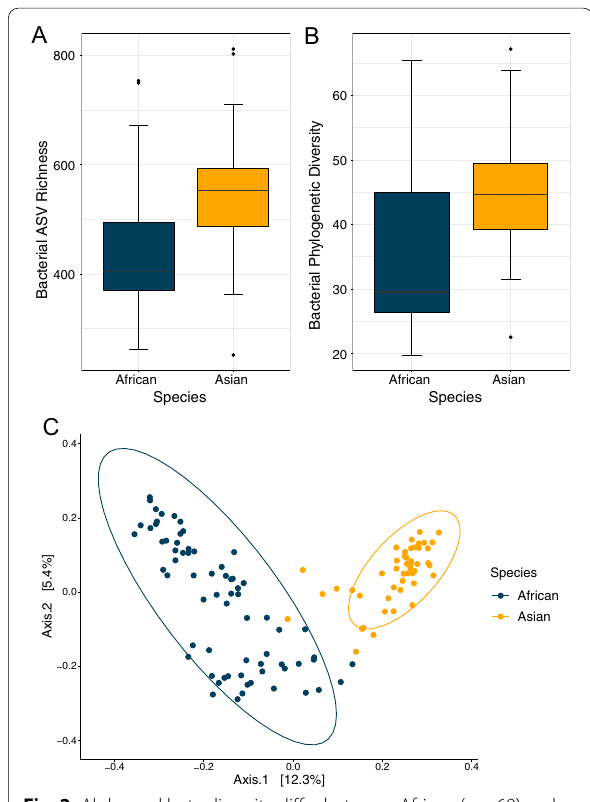
Fig. 2 Alpha and beta diversity differ between African (n 69) and = Asian (n 48) elephant host species. A Box plot of bacterial ASV = richness and B bacterial phylogenetic diversity between host species. Asian elephants had greater bacterial ASV richness and phylogenetic diversity than African elephants (ANOVAs p < 0.001). C PCoA of Bray–Curtis distances (95% confidence ellipses shown per species) showing that African and Asian elephants have distinct gut bacterial communities in compositions (PERMANOVA p 0.001) and dispersion = (PERMDISP p <